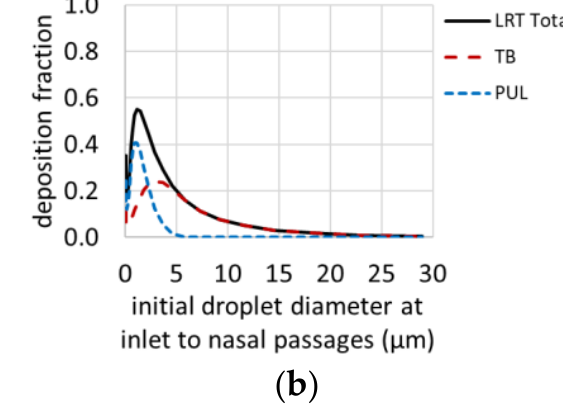
Figure A5 . Plots of example look-up table data of particle deposition fraction versus initial diameter of a particle at the inlet to the nasal passages of a susceptible person including deposition in ( a ) the URT (red), LRT (blue), and total URT and LRT (black), and ( b ) the tracheobronchial region (TB) (red), pulmonary region (PUL) (blue), and total TB and PUL, or LRT (black). At the inlet to the nasal passages, initial properties are a particle composition of 74% well-mixed nonvolatile components (NaCl) and 26% water by mass, air and particle temperatures of 20 ◦ C, and relative humidity of 50%. A dose response model is typically used to determine the probability of infection, P infect . Adopting the standard form of a probit model (see Equation (14) in Figure A4), P infect is taken to be a function of the total deposited dose D total (in virions, TCID 50 , PFUs, etc.), the median infectious dose ID 50 (in equivalent units), and probit slope β ; note that here, D total and ID 50 are measured in terms of TCID 50